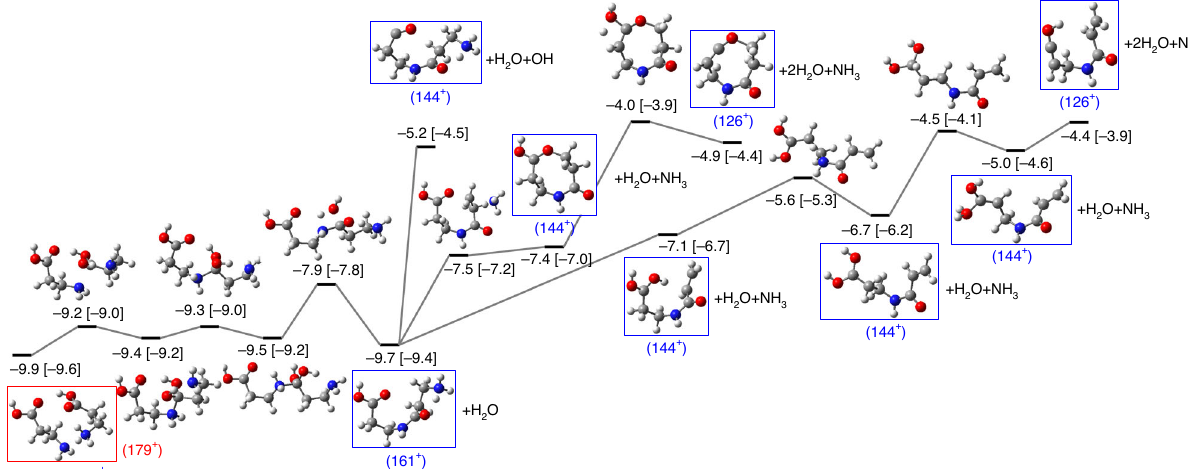
Fig. 2 Potential energy surface exploration of the singly charged protonated dimer. Fragmentation pathways starting from the singly charged protonated dimer ( m / z = 179) showing the formation of the dipeptide ( m / z = 161, noted 161 + ) and fragments ( m / z = 144) and ( m / z = 126), respectively noted 144 + and 126 + . Red box: initial con fi guration; blue boxes: observed fragments. Notice that the 1st vertical ionization potential for the neutral dimer is 9.7 eV, i.e., after proton transfer the dimer is highly stabilized. Geometries optimized at the DFT-M062X/6-311 ++ G(d,p) level of theory. Relative energies (in eV) computed at the CCSD/6-311 ++ G(d,p) level over the geometry previously obtained and referred to the most stable neutral dimer are given next the molecular structures. In square brackets: relative energy computed with DFT-M062X/6-311 ++ G(d,p). H atoms are given in white, C atoms in gray, N atoms in blue, and O atoms in red.